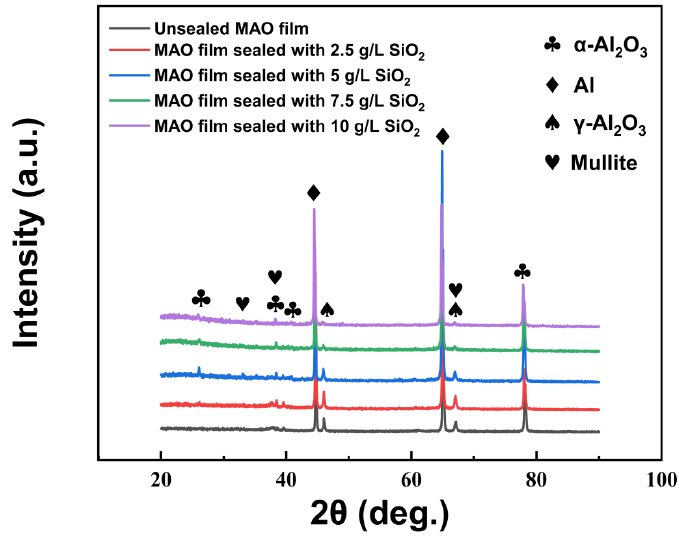
Figure 4. XRD patterns of MAO film and MAO films sealed by SiO 2 nanoparticles.